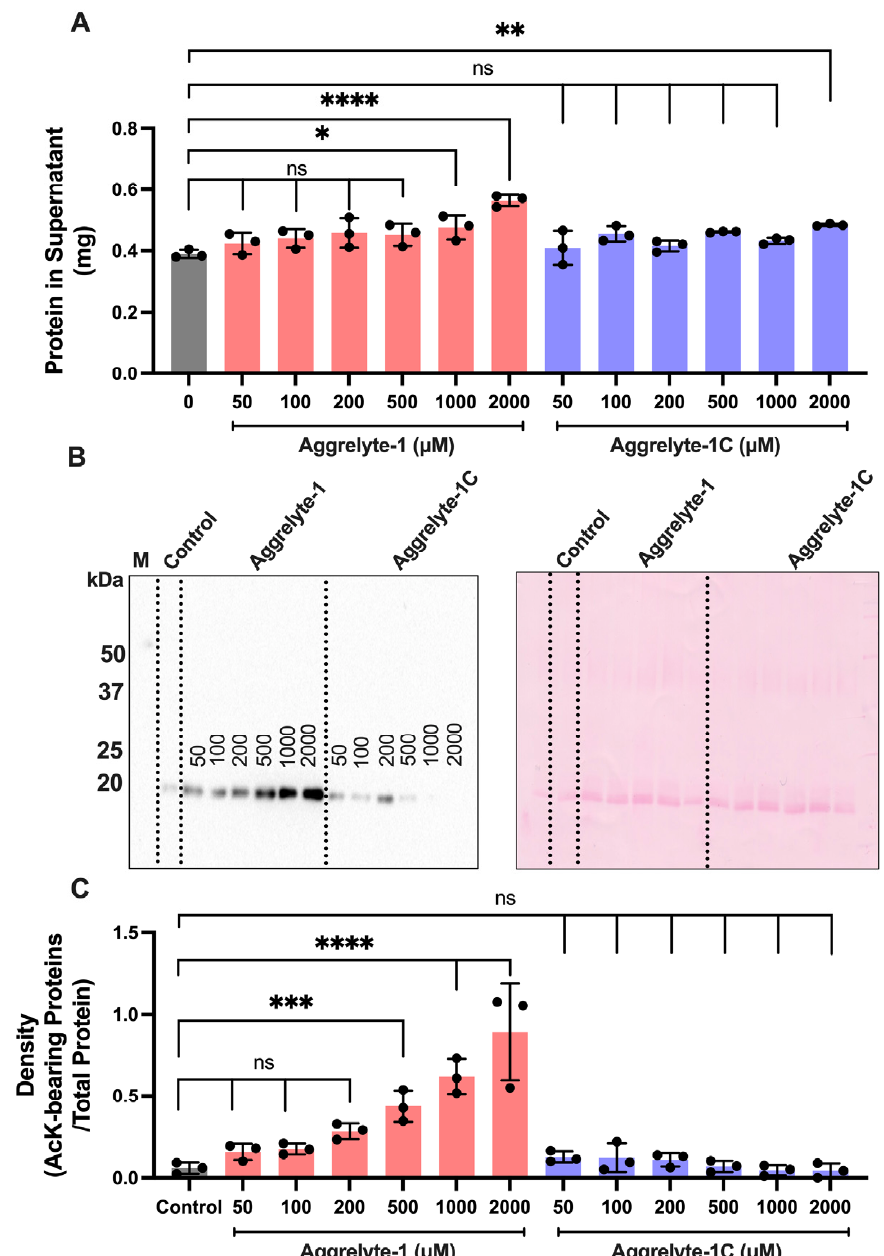
Figure 2. Aggrelyte concentration-dependent solubilization and acetylation of human lens WI. Two milligrams of WI from a human lens (75 years) were suspended in 0.4 mL of 50 mM phosphate buffer, pH 7.4, and the suspension was treated with varying concentrations of aggrelyte-1 or aggrelyte-1C (0–2000 µ M) for 24 h at 37 ◦ C. The suspension was centrifuged at 20,000 × g for 20 min at 4 ◦ C, and the soluble protein content in the supernatant was determined using the BCA assay ( A ). For each concentration of aggrelytes, the samples were separately processed three times and analyzed. The level of AcK was determined for each sample by Western blotting ( B ). Five micrograms of protein from each sample were used for Western blotting. The ponceau S-stained membrane showed protein loading. The bar graphs represent the density plot of triplicate measurements (mean ± S.D.) ( C ). * p < 0.05, ** p < 0.01, *** p < 0.001, **** p < 0.0001, ns = not significant.